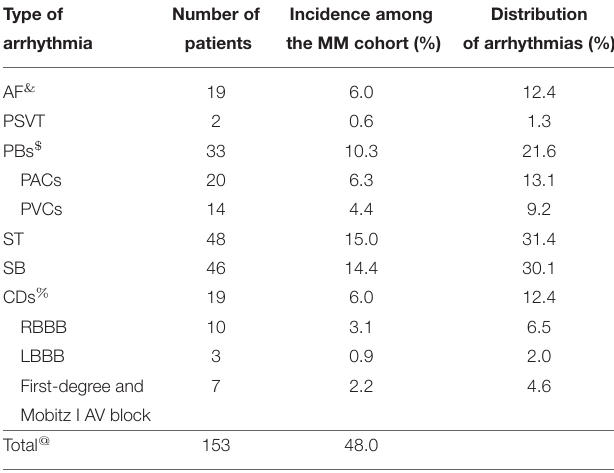
TABLE 2 | Characteristics of arrhythmias in MM